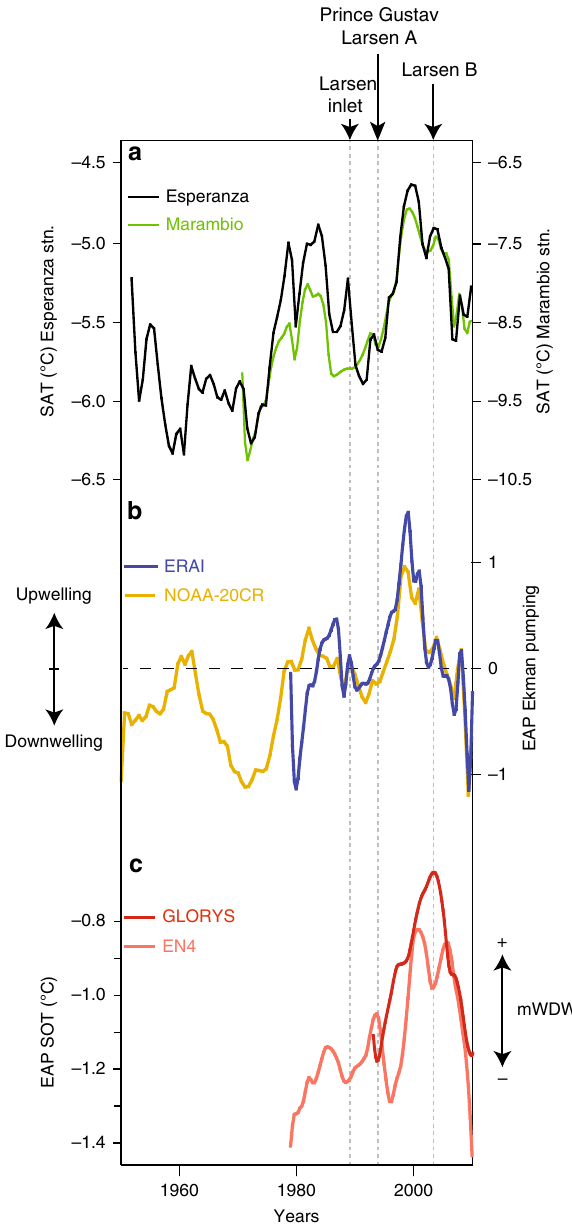
Fig. 2 SAT, Ekman pumping, and SOT variations in the EAP during the instrumental period. a Monitored SAT (°C) at the Esperanza (black) and Marambio (green) stations since 1950 and 1970 25,26 . b Annual mean wind- forced Ekman pumping 16 (normalized series) along the EAP between 1950 and 2010 based on the reanalysis data from 20CR Project version 2 8 (orange) and ERA-interim 13 (blue). c Smoothed Annual mean SOT (°C) from 1993 to 2010 using GLORYS (dark red) 18 and between 1979 and 2010 using EN4 (light red) 19 along the EAP margin at 50 – 400 water depth. Black arrows indicate the major ice shelf collapse events. The smooth fi t (also represented in Fig. 3) is an interpolate curve fi t with a geometric weight applied using a Stineman function to the data. The weight is applied to 20% of the data (±10% of the data range, i.e., around the current